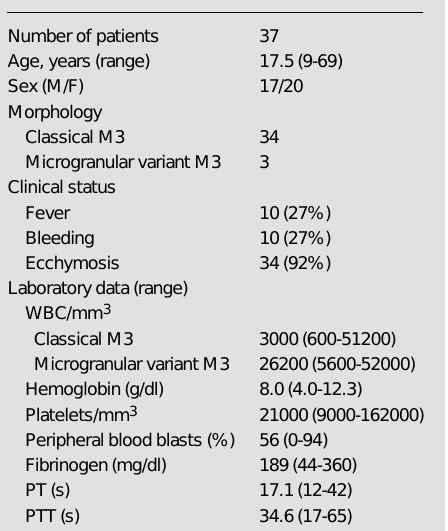
Table 1 - Characterization of the patient population.